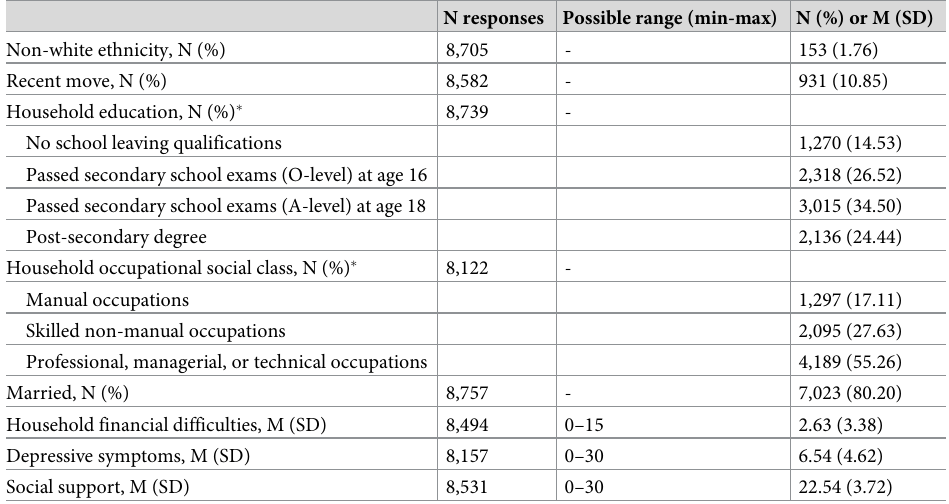
Table 2. Sociodemographic and psychosocial characteristics of the sample